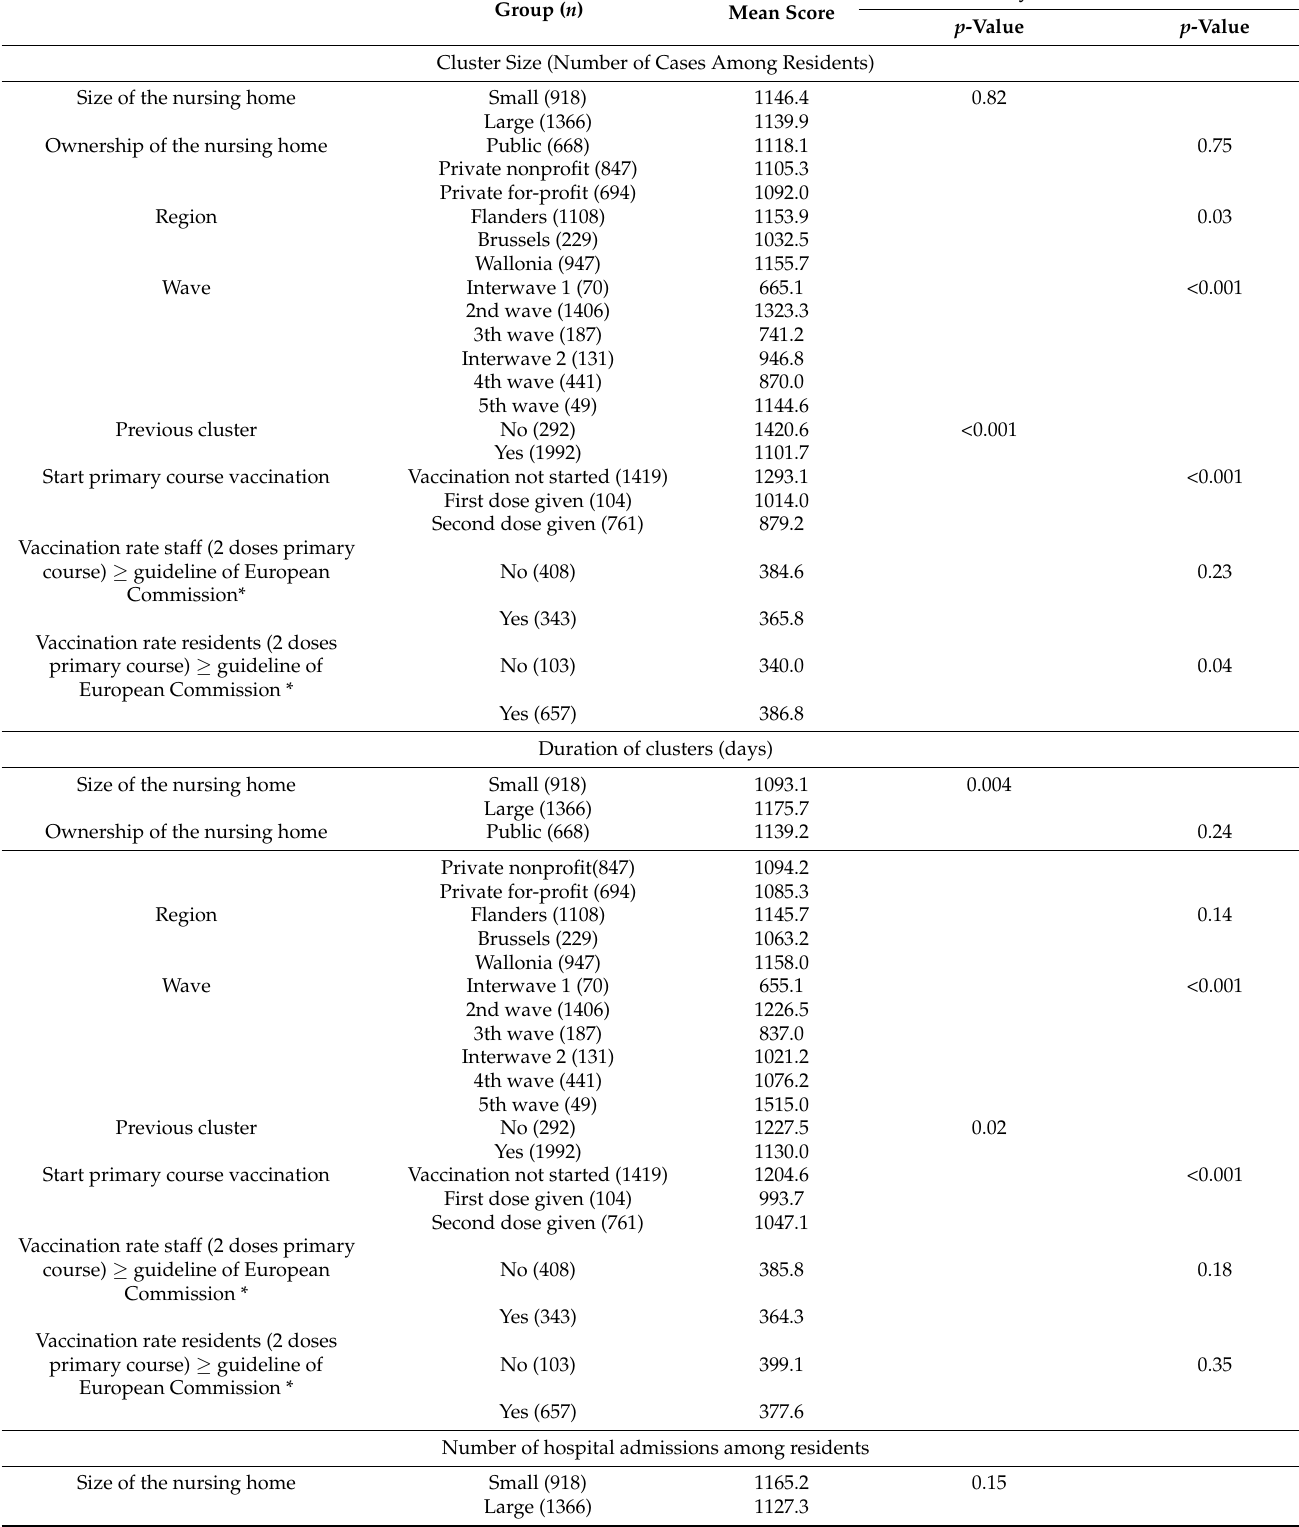
Table 4. Comparison of cluster characteristics (size, duration, number of hospital admissions and deaths among residents) with nursing home features (size, ownership, region, wave, previous cluster experience, vaccination status), using Mann–Whitney U test/Kruskal–Wallis, between 22 June 2020 and 2 January 2022,